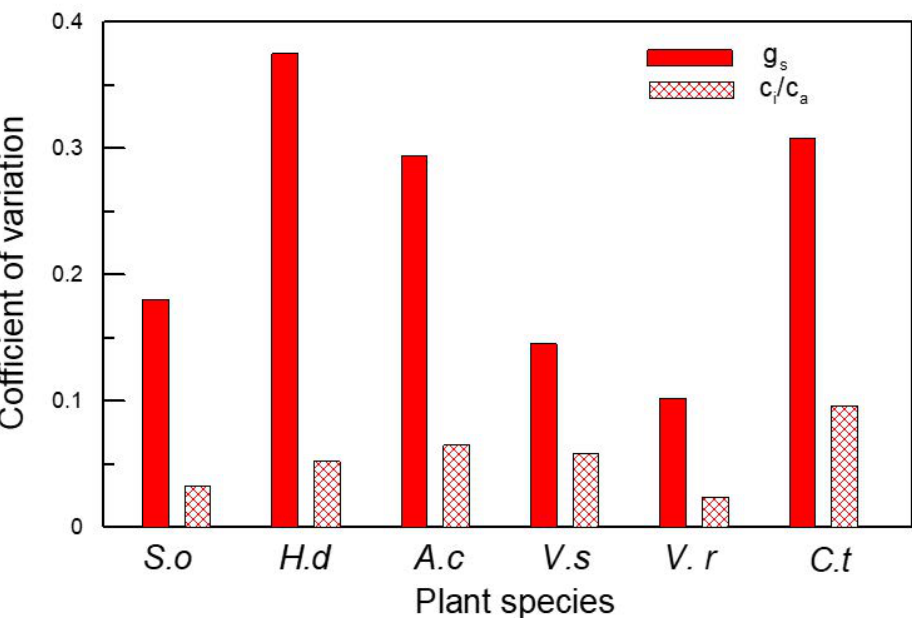
Figure 7. Coefficient of variation of stomatal conductance (g s ) and the ratio of intercellular to ambient CO 2 concentration (c i /c a ) for plants derived from the third sampling campaign. Abbreviation: S.o , S. oblate ; H.d , H. dulcis ; A.c , A. chinensis ; V.s , V. sargentii ; V.r , V. rhytidophyllum and C.t , C. trichotomum .